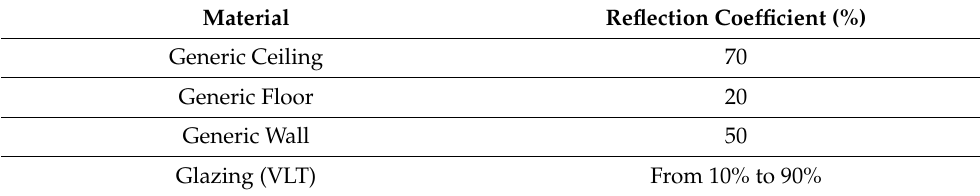
Table 1. Material reflection coefficient